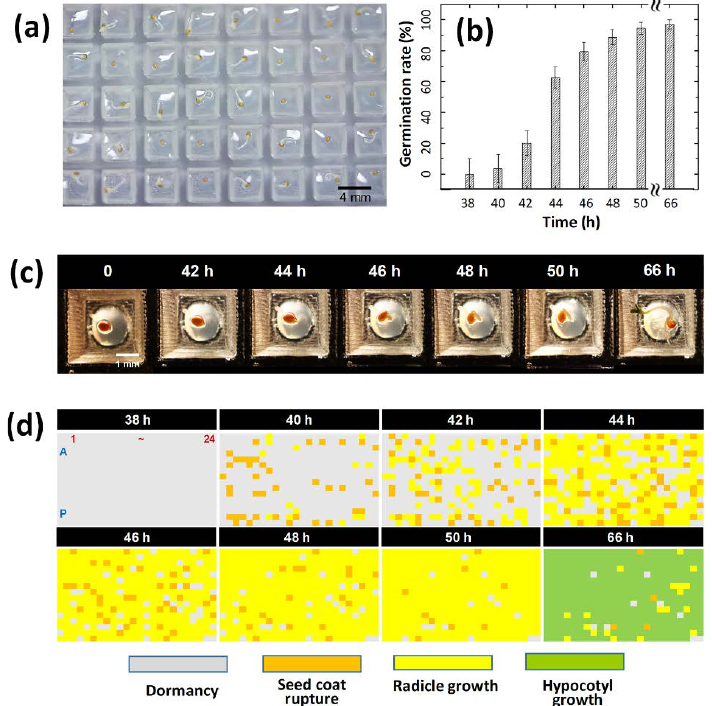
Figure 3. Demonstration of cultivation on the 1 / 25 Murashige and Skoog (MS) medium-conditioned plant array chip. ( a ) Observation photograph of seedlings on the plant array chip from above. ( b )